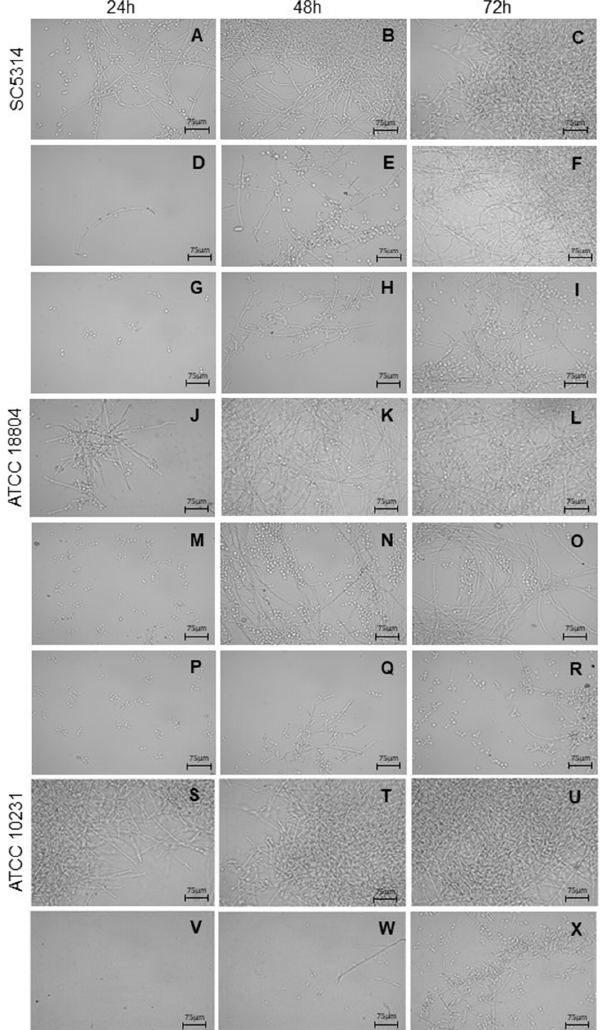
Figure 5. Hyphal formation by Candida albicans strains. C. albicans was cultured in the absence (control) and presence of Bauhinia holophylla extract and fractions at 625, 312.5, and 125 µg/mL for 24, 48, and 72 h at 37 °C. Nystatin was used as a positive control. Only active samples are shown at 625 µg/mL. ( A – C ) C. albicans SC5314 control; ( D – F ) SC5314 with crude hydroethanolic extract; ( G – I ) SC5314 with dichloromethane fraction; ( J – L ) C. albicans ATCC 18804 control; ( M – O ) ATCC 18804 with dichloromethane fraction; ( P – R ) ATCC 18804 with ethyl acetate fraction; ( S – U ) C. albi- cans ATCC 10231 control; ( V – X ) ATCC 10231 with hydroethanolic fraction. Representative micro- photographs were obtained using 400-fold magnification. Scale bars: 75 µM.